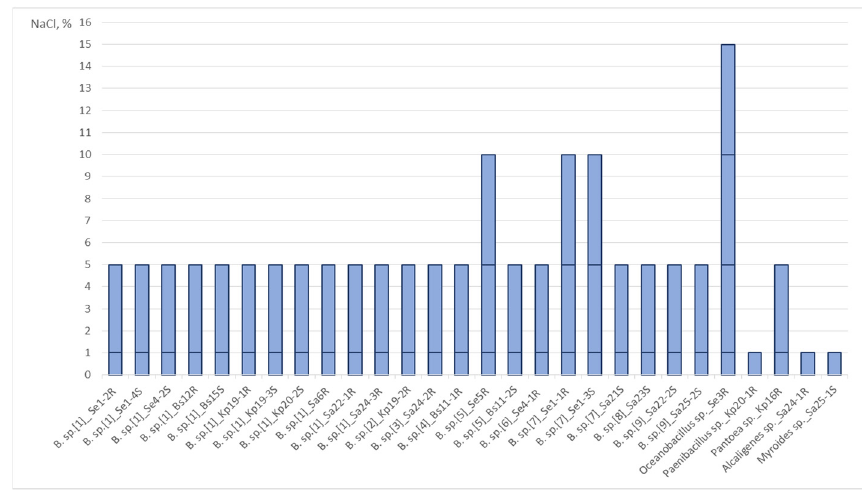
Figure 2. The Effect of Different Concentrations of NaCl on the Growth of Endophytes.